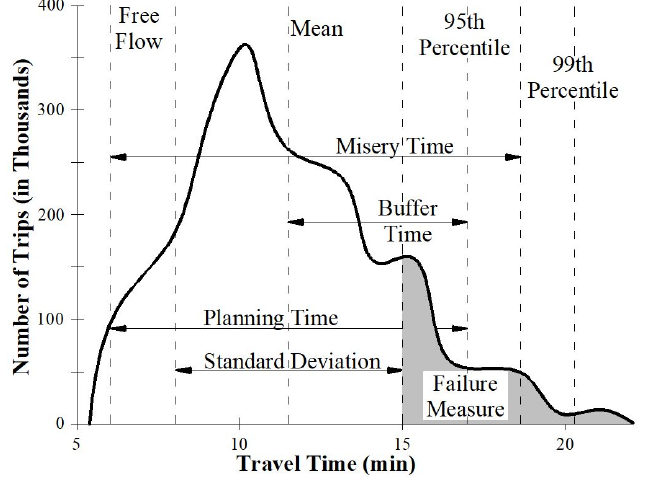
Figure 2. Chart with measures of the time buffer method.